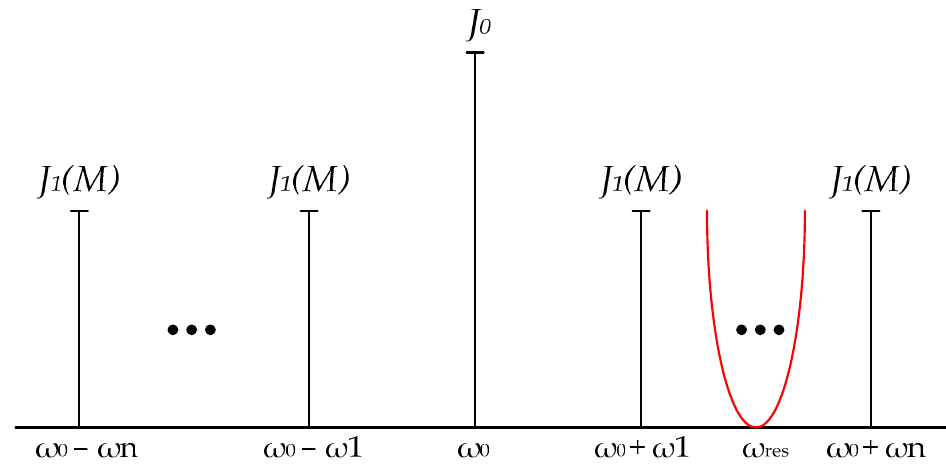
Figure 2. OEO spectrum and generating principle.